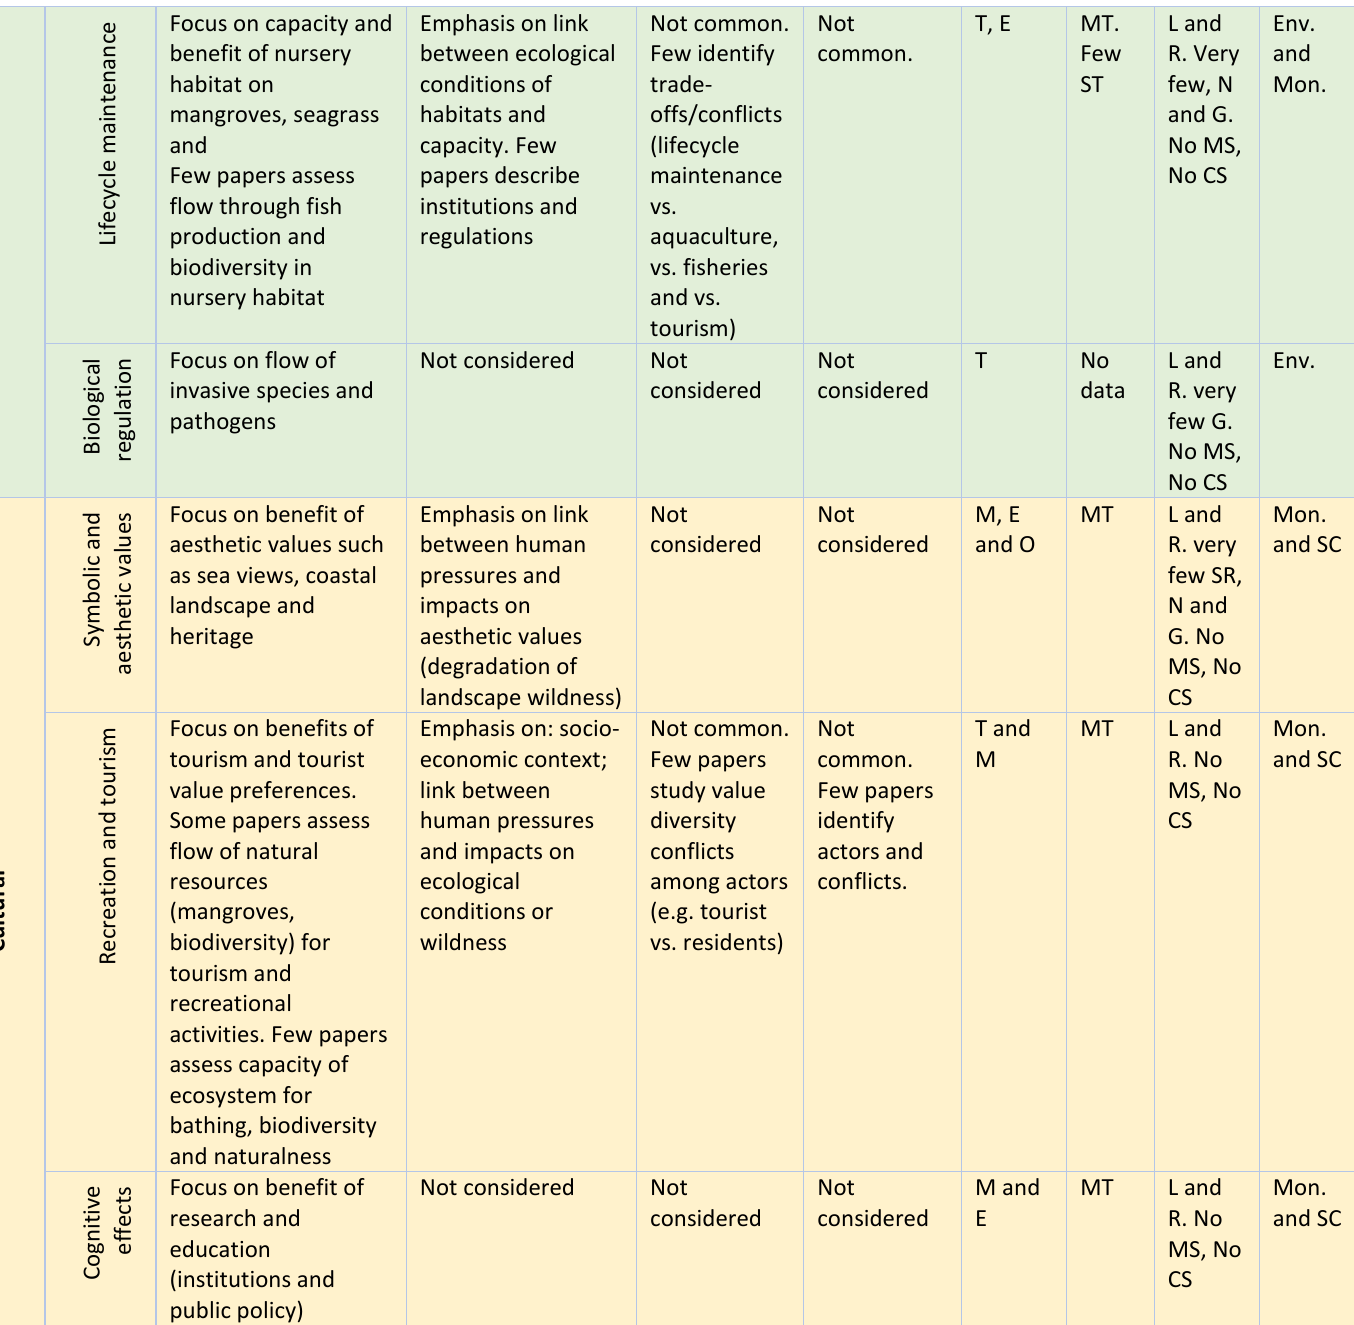
Table 1. The majority of the reviewed manuscripts contain significant gaps regarding socio-ecological components. They fail to integrate some of the cascade components, especially flow. The papers do not completely embrace coproduction and power relations, and neither do they assess uncertainty, value pluralism and spatial and temporal scales interactions. † T= Technical; M=Methodological; E=Epistemological; O=Ontological ‡ MT= Medium-term; ST= Short-term; MS=Multiscale; CS=Cross-scale § L=Local; R=Regional; LT= Long-term. | Mon.= Monetary; Env.= Environmental; SC.=